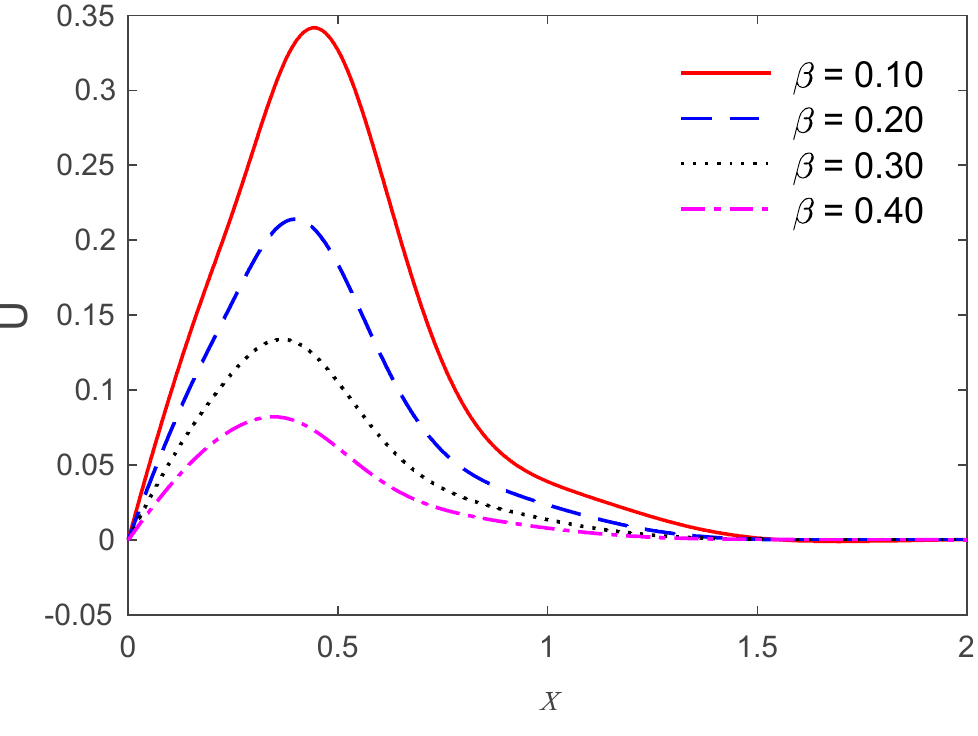
Figure 9. The effects of porosity on the fluid displacement variations.